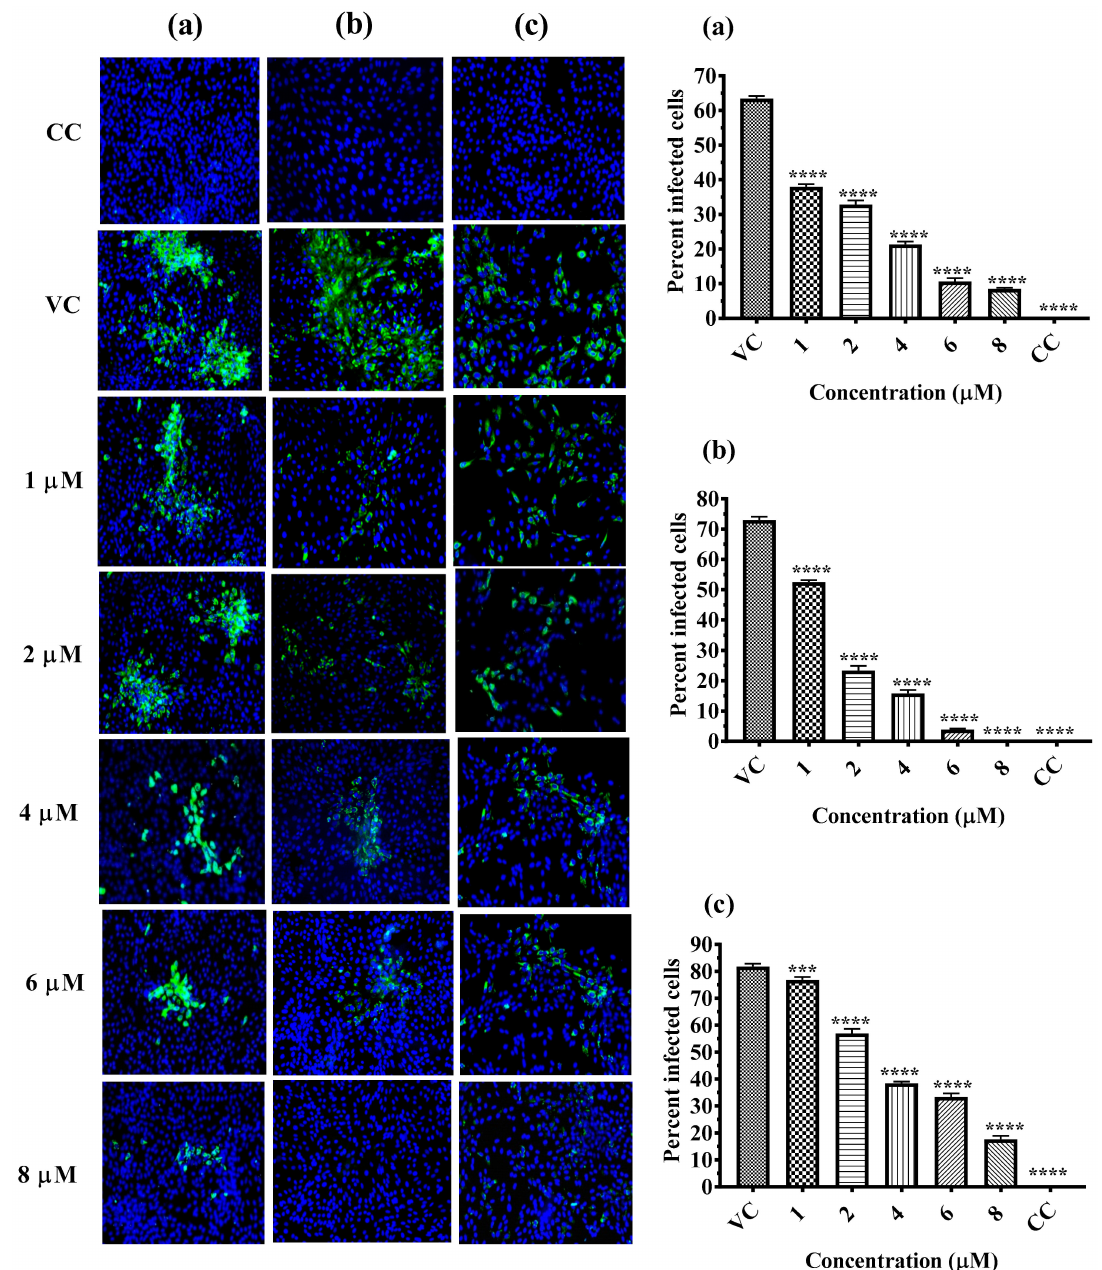
Figure 3. Microscopic images of Immunofluorescence assay. Immunoflourescent images of DENV-2 infected Vero ccl81 cell lines under pre-treatment, co-treatment and post-treatment conditions. Virus infected cells appear green in color Percentage of infected Vero ccl81 cell line in cultures infected with virus with different concentrations of compound under pre-treatment ( a ), co-treatment a ( b ) and post-treatment ( c ) conditions. All the values are expressed as mean ± SD of three experiments ****, p < 0.0001 and ***, p = 0.0002 vs.